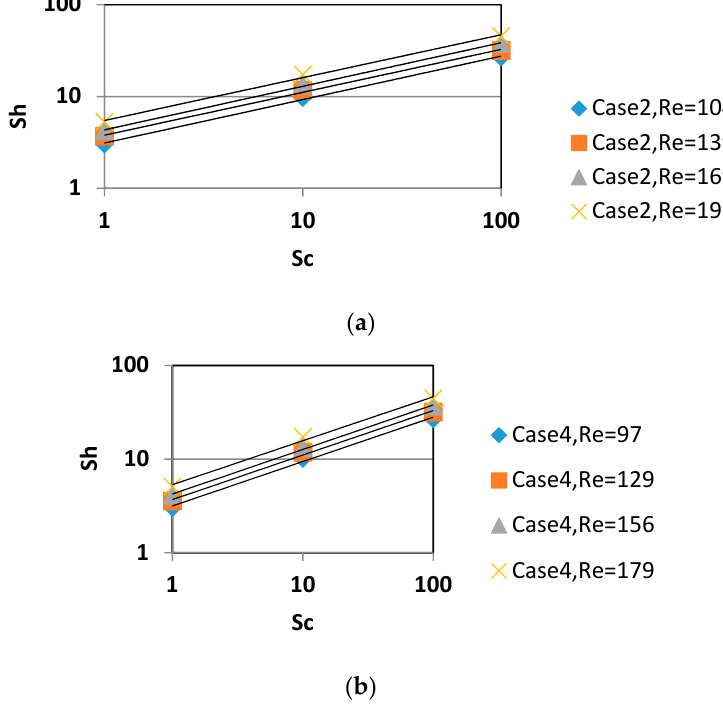
Figure A4. Time and space-average Sh number on the membrane surface as a function of Sc number for ( a ) h / D = 0.05; and ( b ) h / D = 0.10.